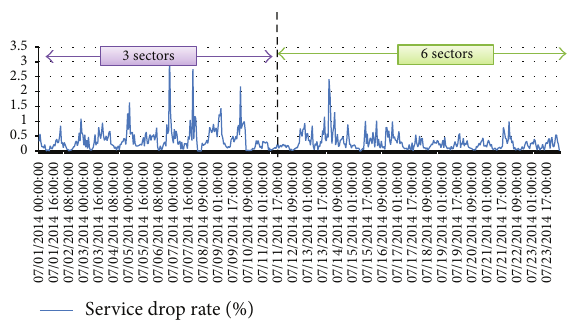
Figure 9: The site service drop rate before and after the 6-sector